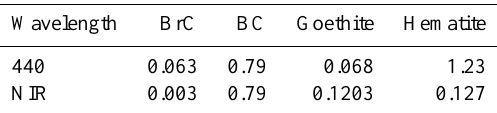
Table 1. Imaginary indices at 440nm and RNIR (average of 670, 870, and 1020nm) assumed for each component in the retrieval of Schuster et al. (2015a).